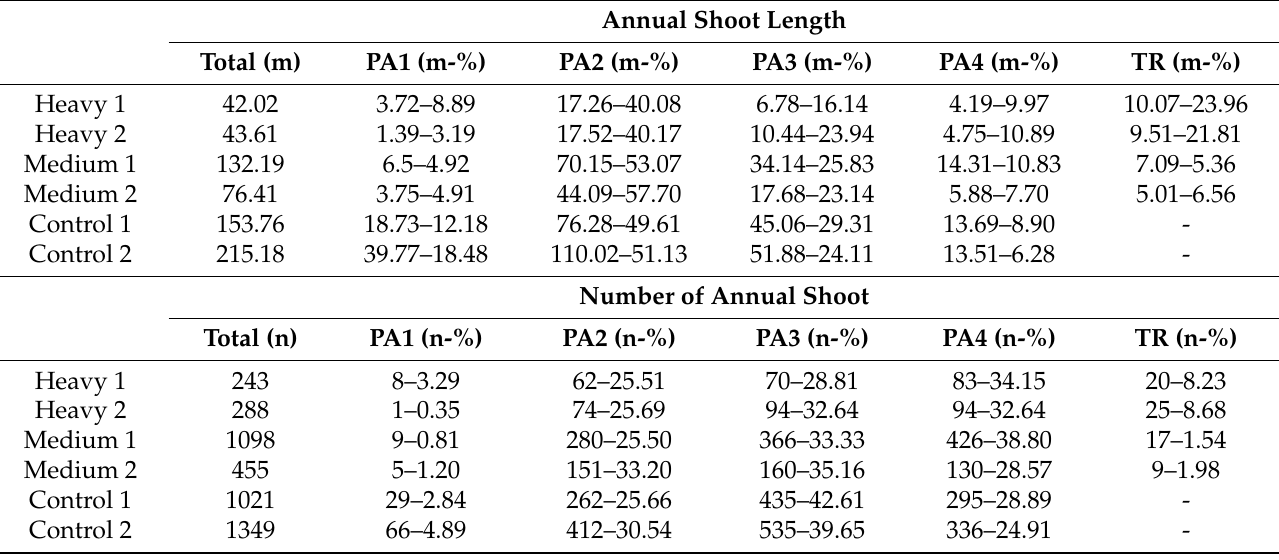
Table 3. Length and annual shoot number in six red ashes from a tree trimming experiment. The total (number or length) as well as the total for each classified annual shoot types are presented (ST1 to 4 and traumatic reiterations,